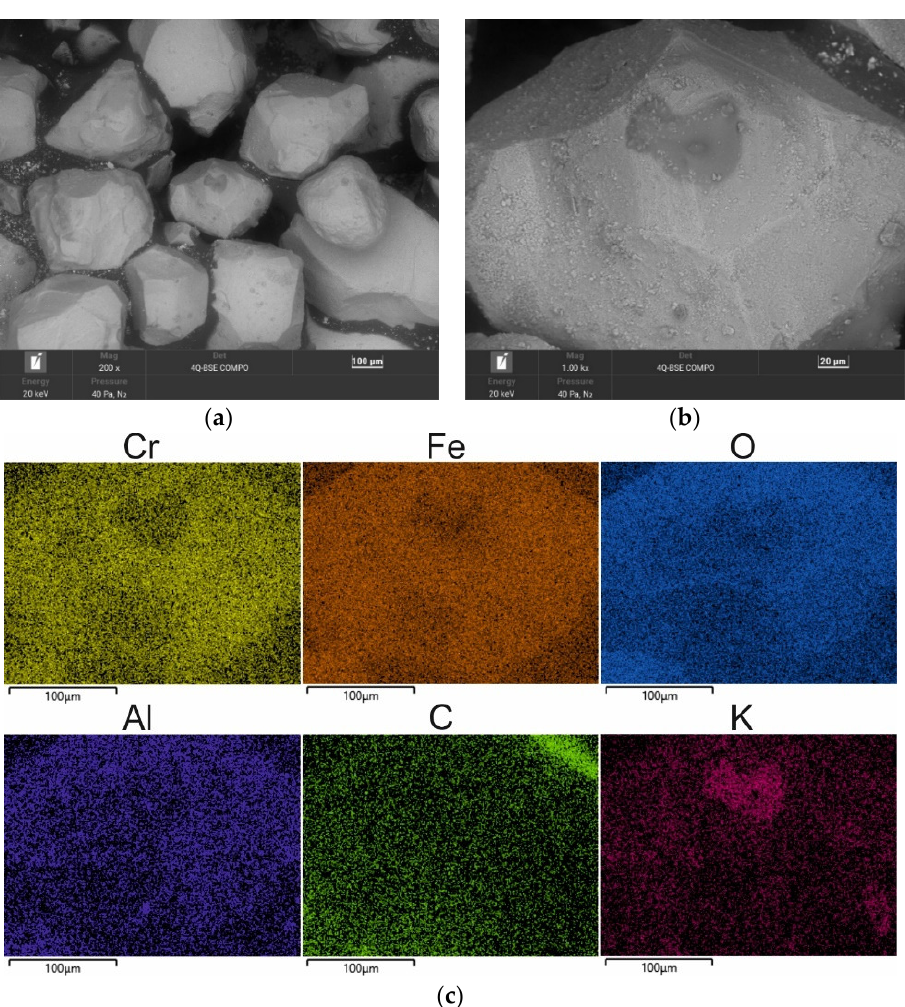
Figure 16. SEM image of spent sand SS after roasting for 2 h at 1000 °C: ( a ) mag. 200×; ( b ) mag. 1,000×; ( c ) EDS map of element distribution in the analysed area of spent sand SS after roasting.